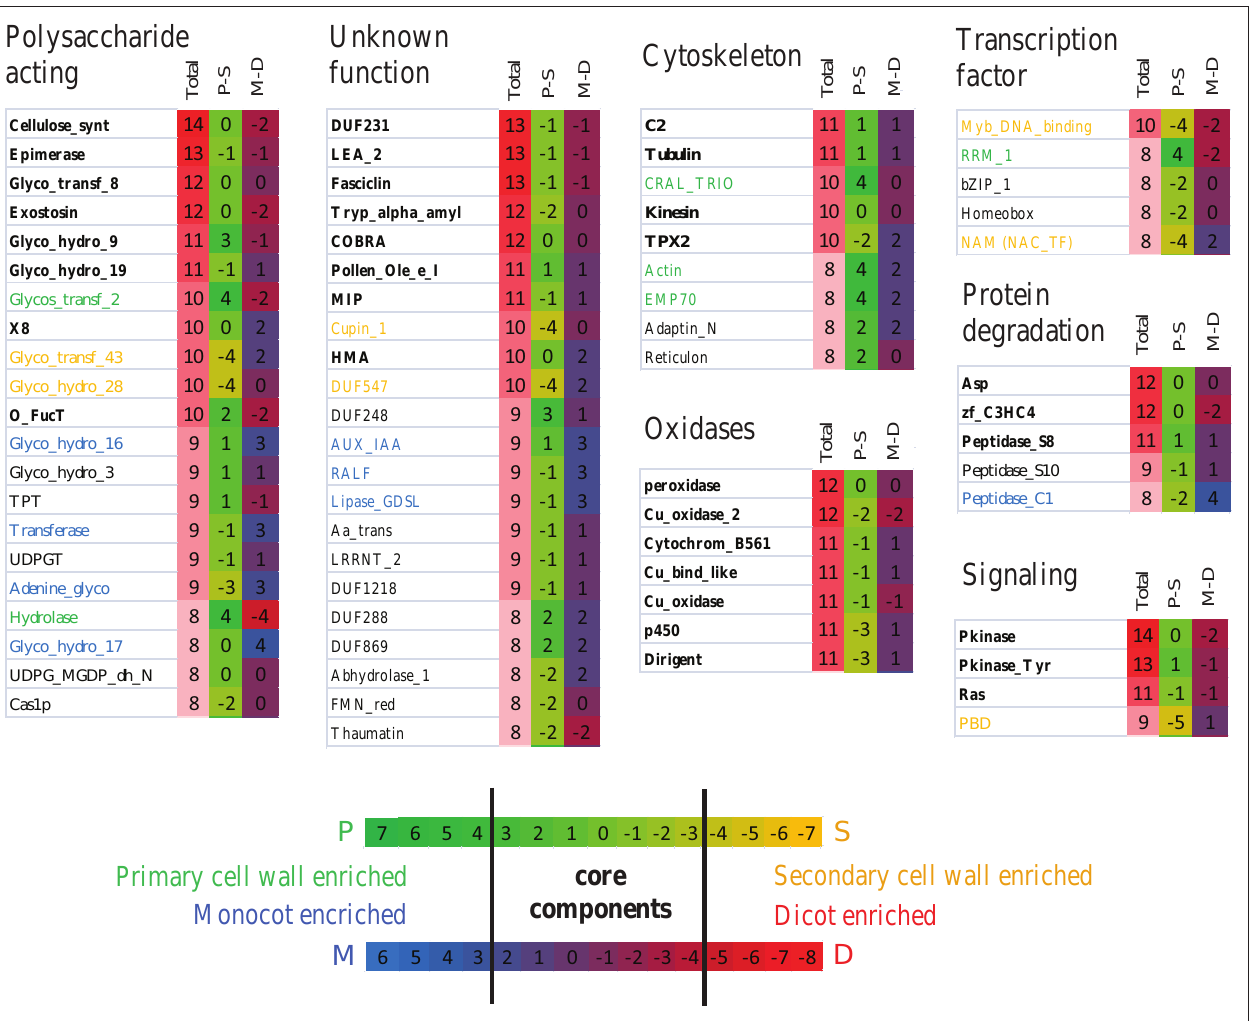
the difference of P − S is − 4 (second column). At the same time, genes from this NAM family are present in five monocot (M) and three dicot (D) co-expression networks resulting in a difference M − D of two (third column). Any PFAM was defined as enriched in primary or secondary cell walls and marked green or orange, if P − S ³ 4 or P − S £ − 4, respectively. Enrichment for monocots or dicots, with corresponding PFAMs marked in blue and red, was defined as M − D ³ 3 or M − D £ − 5, respectively, because eight dicot and only six monocot networks (corresponding to four dicot and three monocot species) were analyzed. Core components (marked in bold letters) were defined as gene families that were present in at least ten networks, without being enriched in monocots or dicots, nor primary or secondary cell